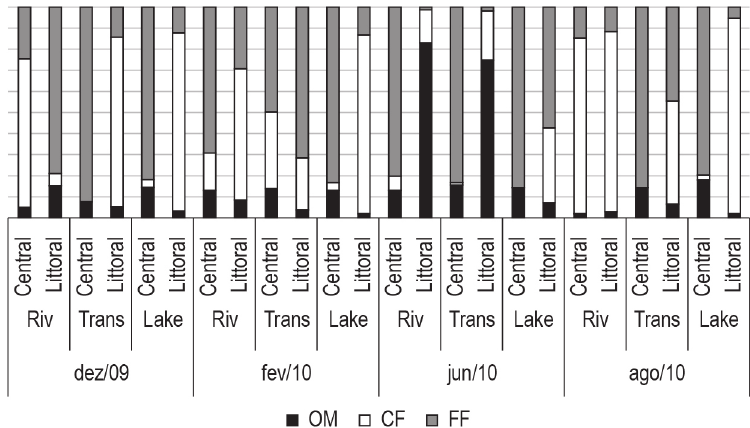
Figure 4. Proportions of organic (OM) and inorganic coarse and fine fractions of the sediments from Itupararanga reservoir, SP, Brazil considering central and littoral regions along riverine (Riv), transitional (Trans) and lacustrine (Lake) zones.